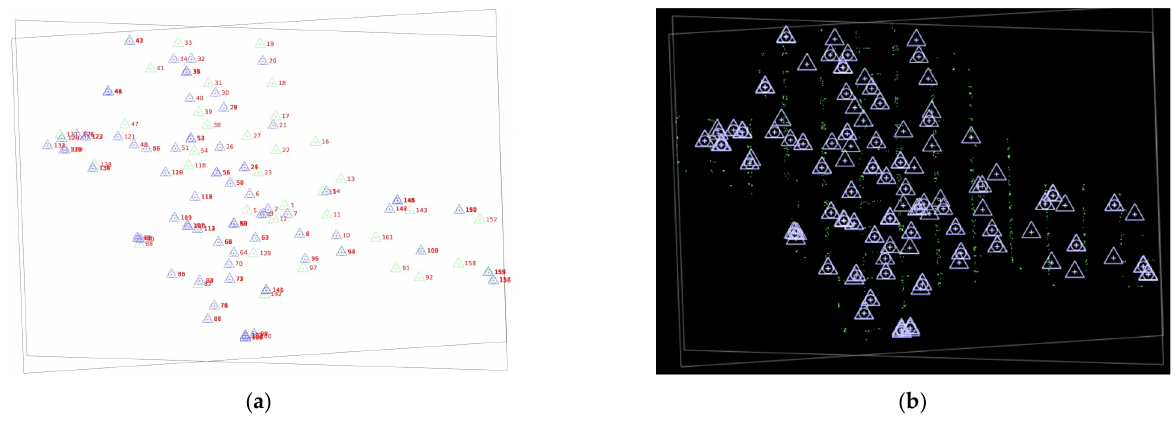
Figure 18. ( a ) Distribution of GCPs (blue color) and ChPs (green color); ( b ) TPs (green) automatically extracted from GCPs and ChPs.